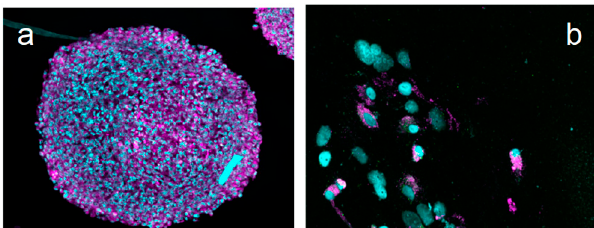
Figure 9. ( a ) Fluorescence imaging of a U87 MG cells spheroid section after 24 h exposure with Au@DTDTPA-Cy5 nanoparticles. ( b ) Fluorescence imaging of U87 MG single cells obtained after spheroid dissociation. Pink fluorescent signal corresponding to Cy5 was found in the cytoplasm, while cell nuclei were labeled with Hoechst 33342 (blue fluorescent signal).